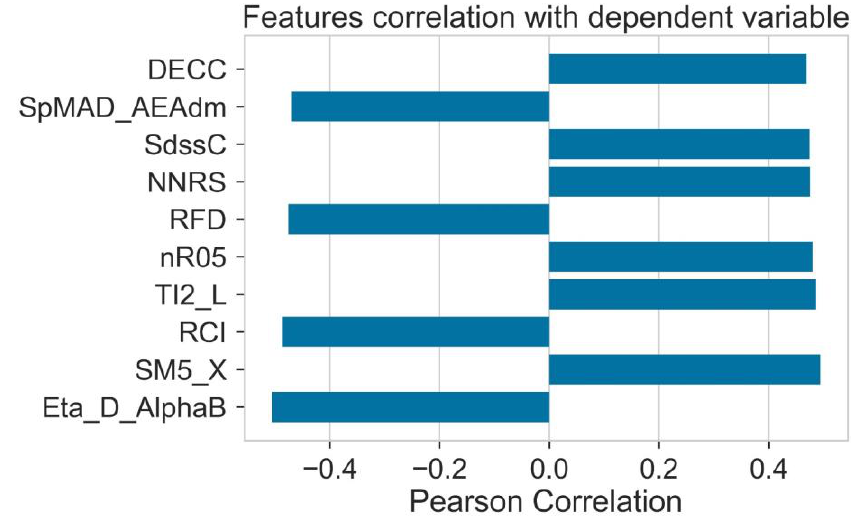
Figure 2. Correlation of features with HOMO.